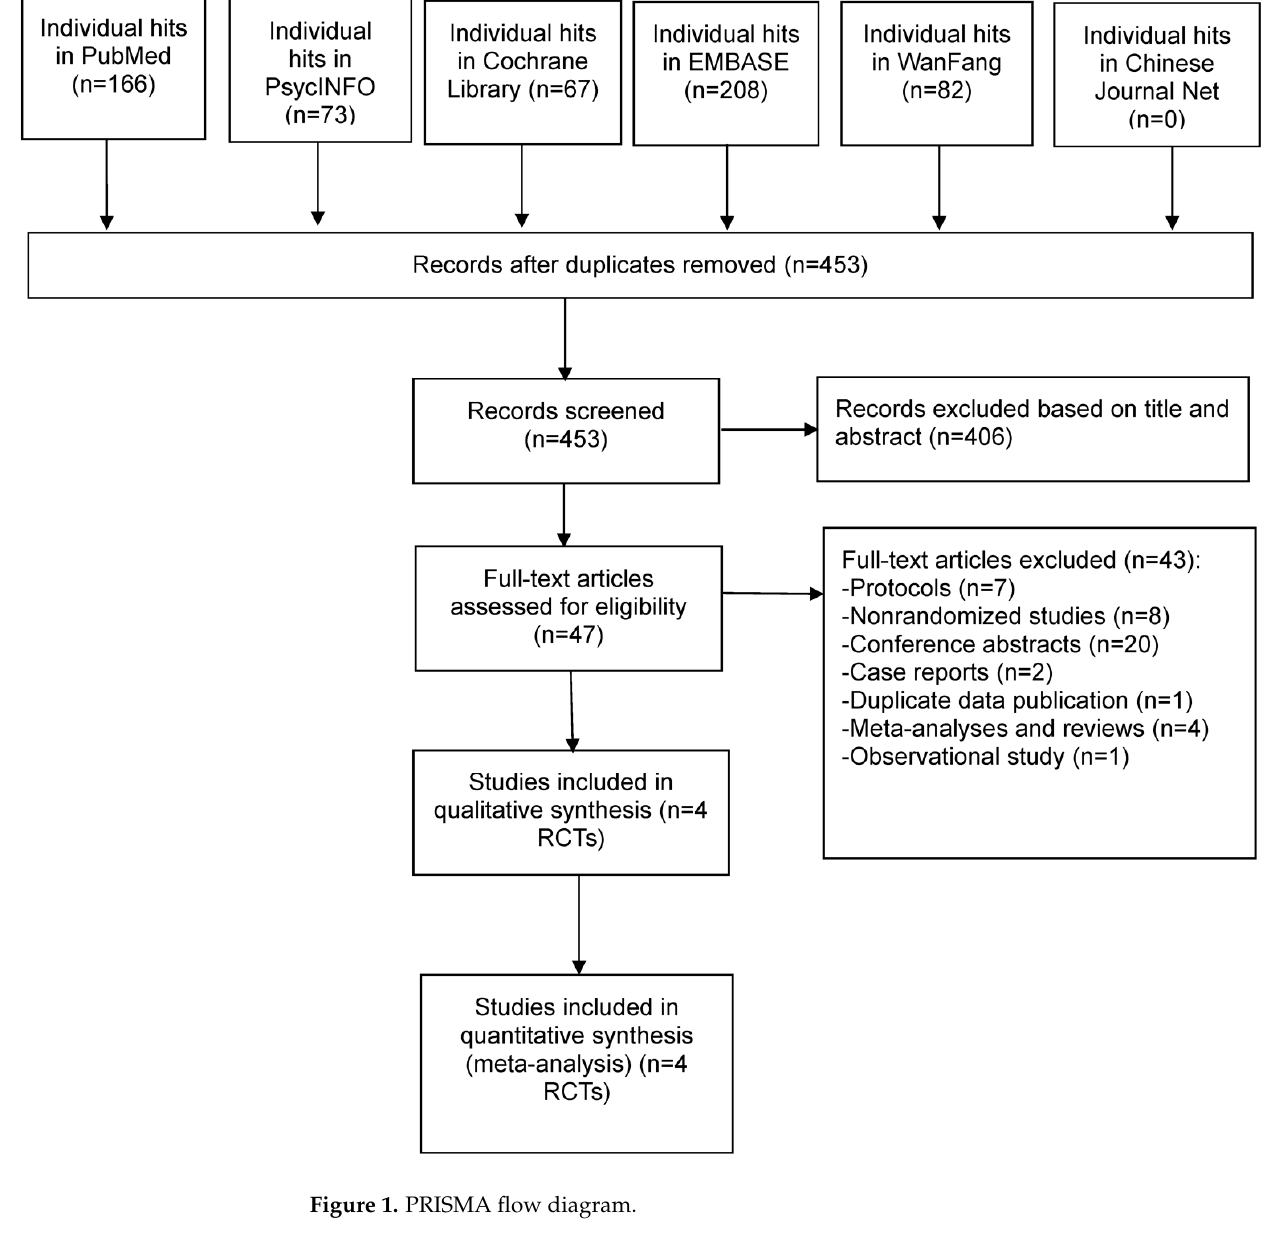
Figure 1. PRISMA flow diagram.